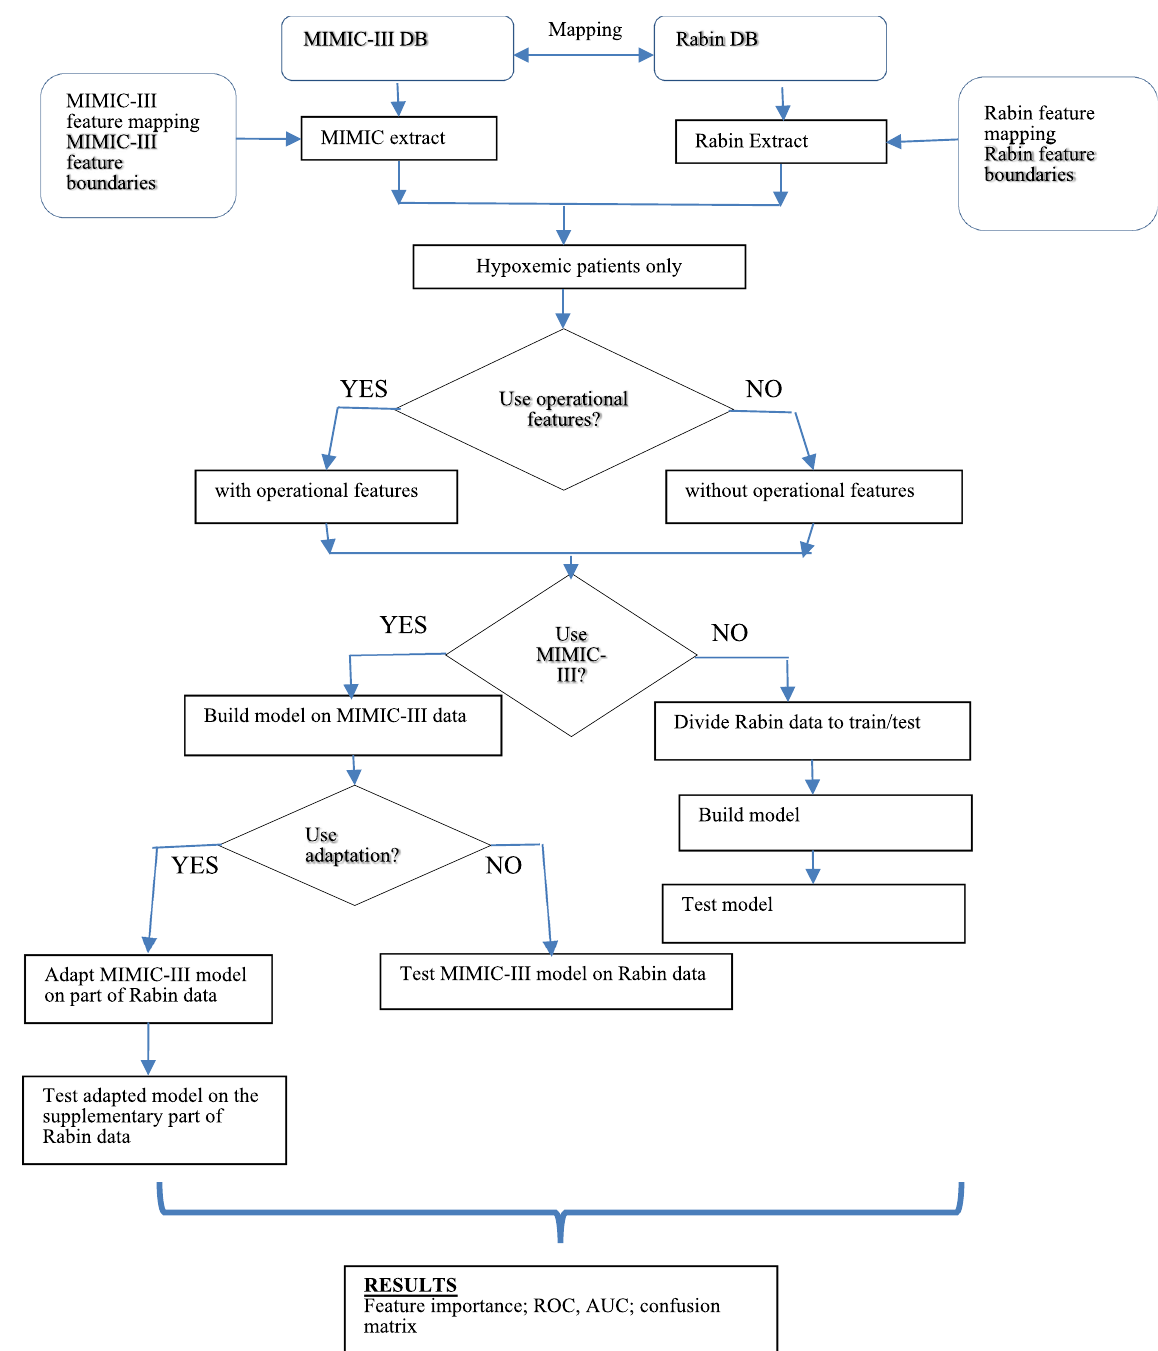
Figure 2. Processing flow diagram. Model training and testing is done in two configurations: with and without the operational features. Model for Rabin data may be pre-trained on MIMIC-III or without it. Finally, the model trained on MIMIC-III could be adapted to the Rabin data or tested as is . MIMIC-III: medical information mart for intensive care III. DB: database. ROC: receiver operator characteristic. AUC: area under the